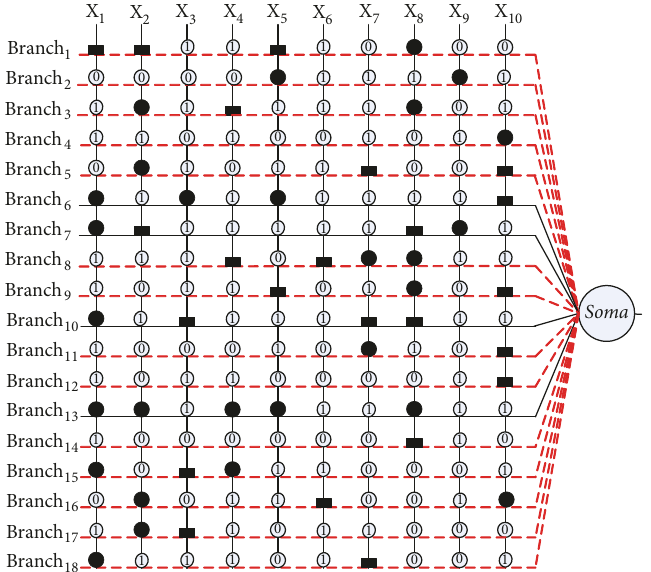
Figure 13: The dendritic morphology of the Distress data set after dendritic pruning.